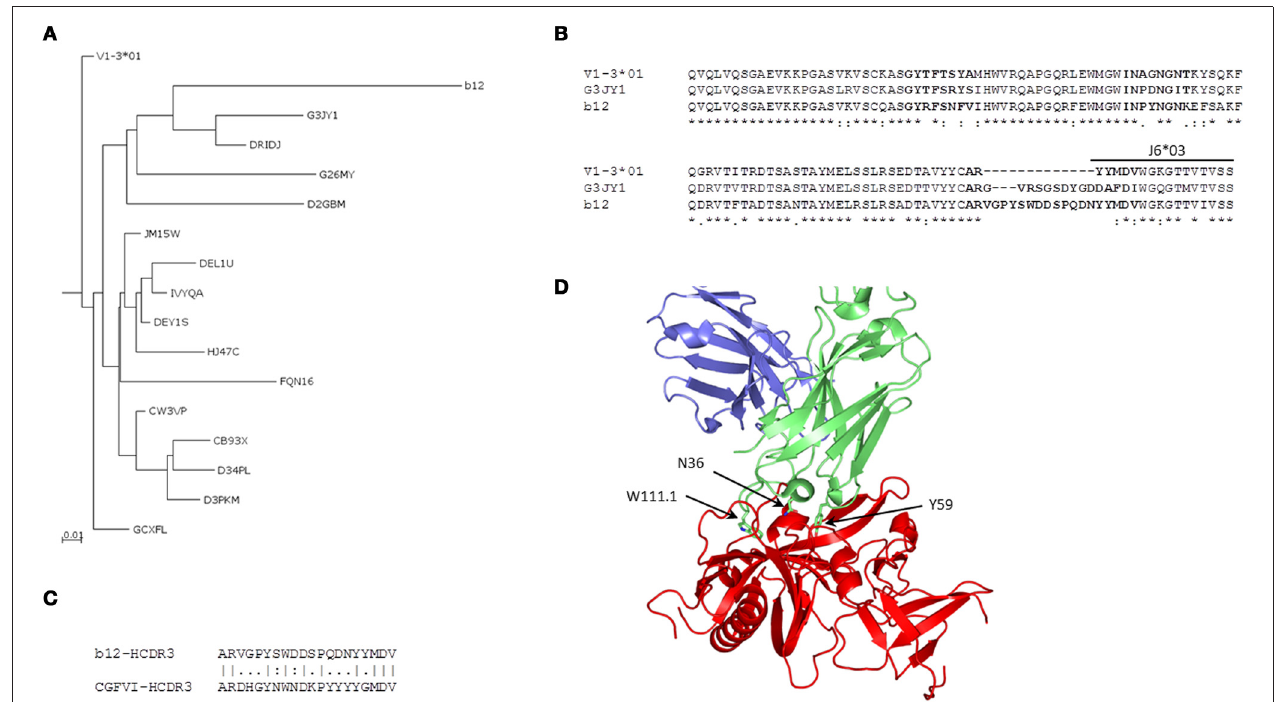
FIGURE 5 | Phylogenetic and somatic mutation analyses of anti-HIV bnAb b12. (A) A phylogenetic sub-tree constructed from a total of 169 unique sequences from the HV1-3 subgroup, which were obtained from the 454 sequence analysis of a human IgM library, along with the heavy chain V1-3 ∗ 01 germline and V H sequence of b12 antibody showing the evolutionary relationship among different intermediates. Five-letter alphanumeric codes denote sequence labels as used in the pyrosequencing. (B) Multiple sequence alignment shows the differences in aa sequence between